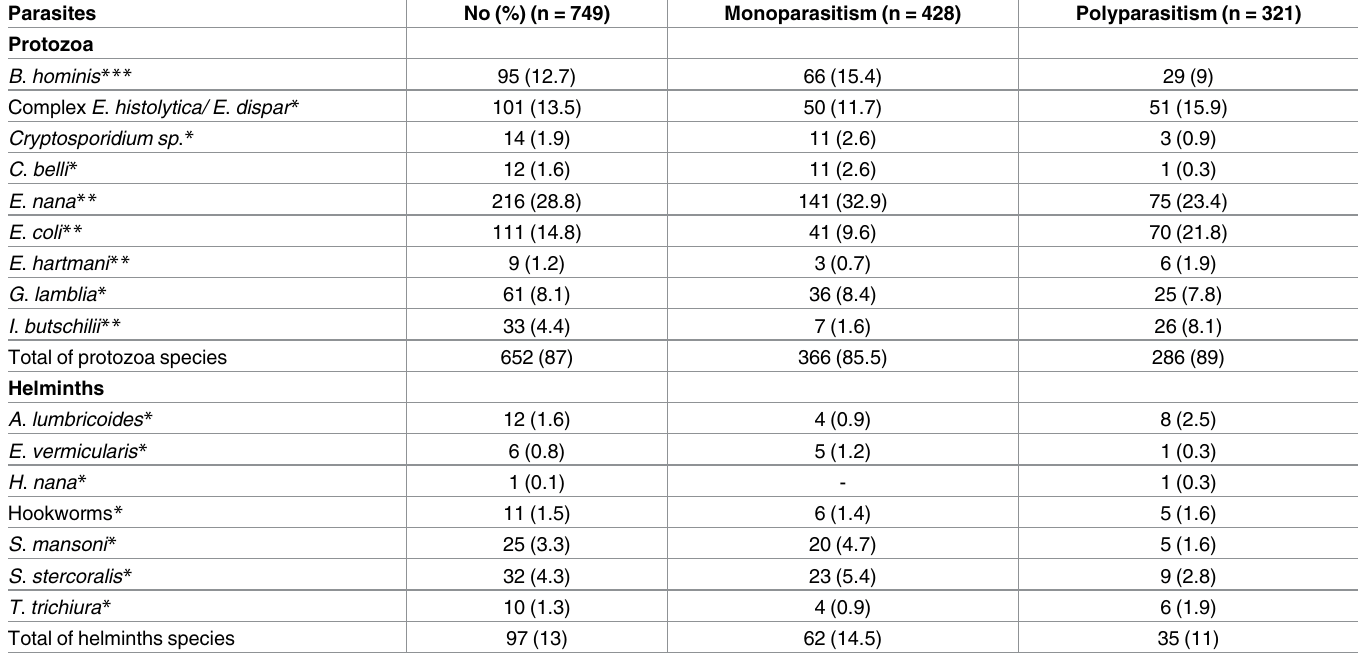
Table 4. Number of intestinal protozoa and helminths species: Monoparasitism and polyparasitism.